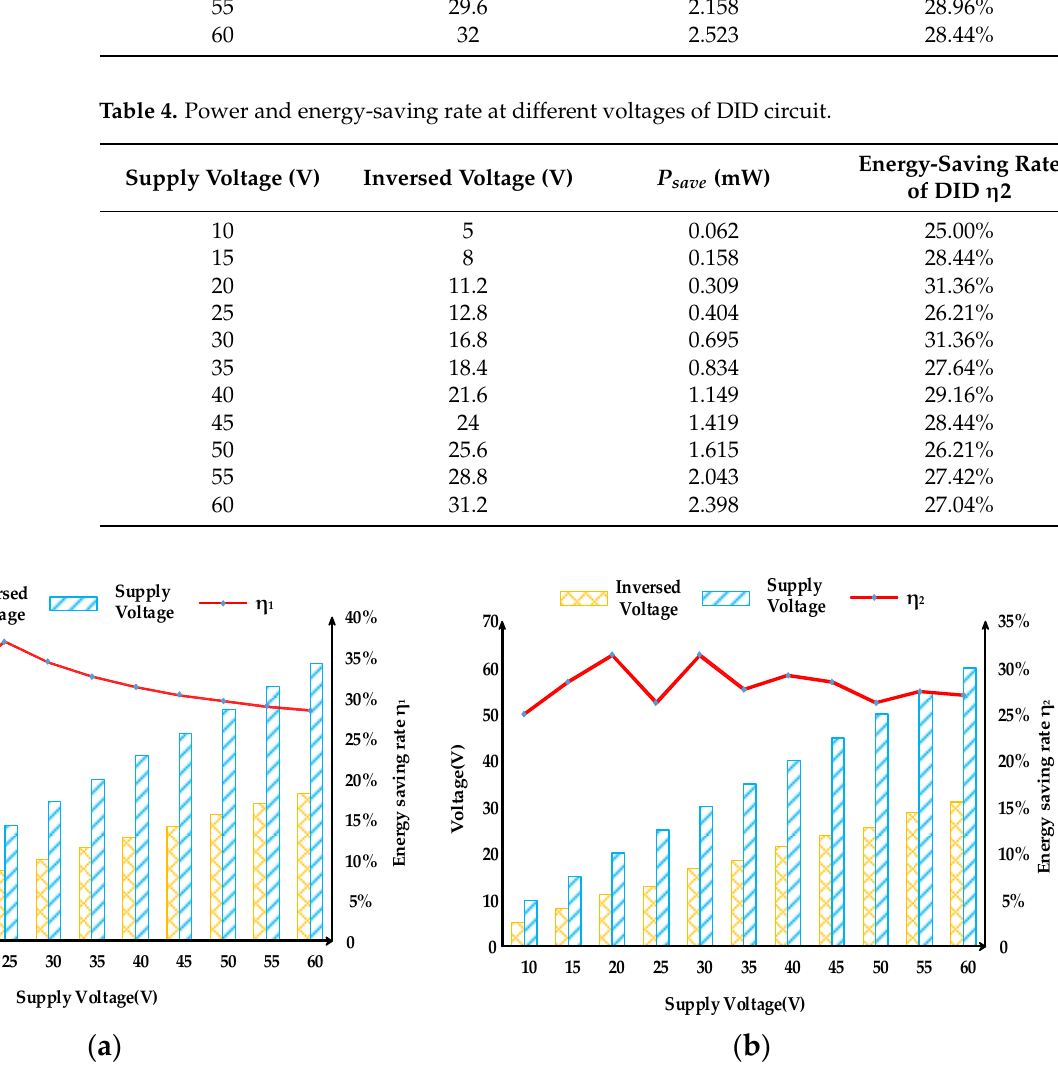
Figure 14. Energy-saving rate curves at different voltages of ( a ) SID circuit ( b ) DID circuit.